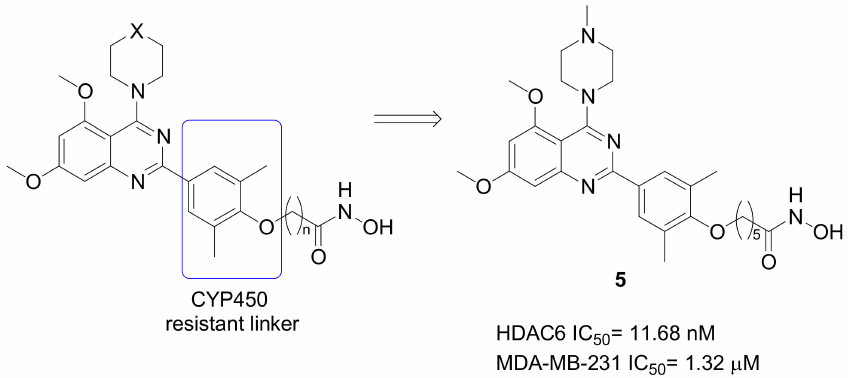
Figure 6. Chemical structures of CYP450 resistant quinazoline-derivatives as Class-IIb HDACIs effective against